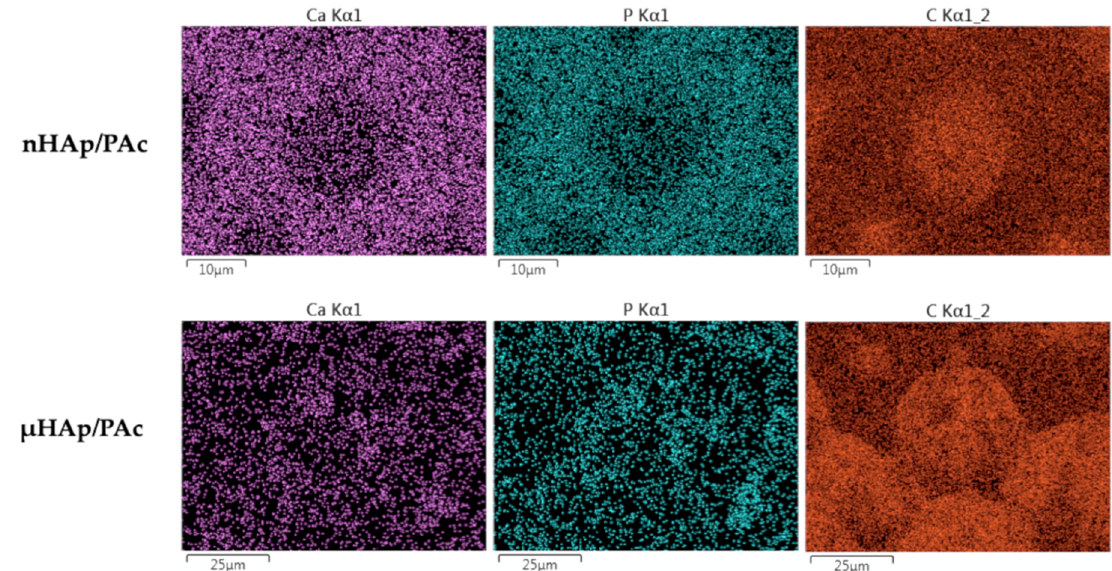
Figure 10. Examples of calcium, phosphorus, and carbon distribution maps in the nHAp/PAc and µHAp/Pac composite materials.